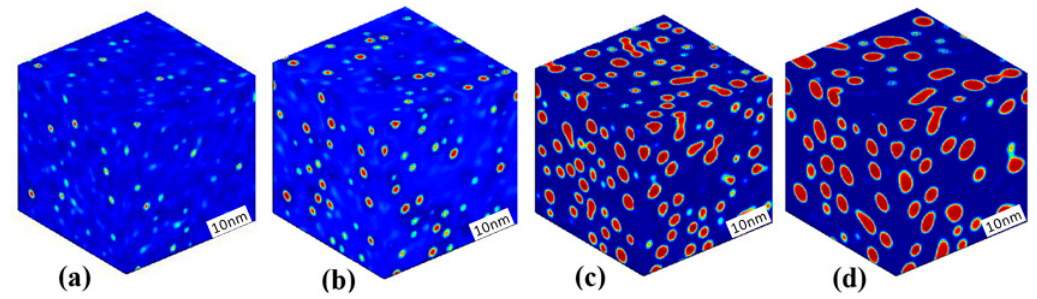
Figure 5. 3D morphology of the Cr-enriched α′ phase in the Fe-30 at % Cr alloy aged at 750 K,